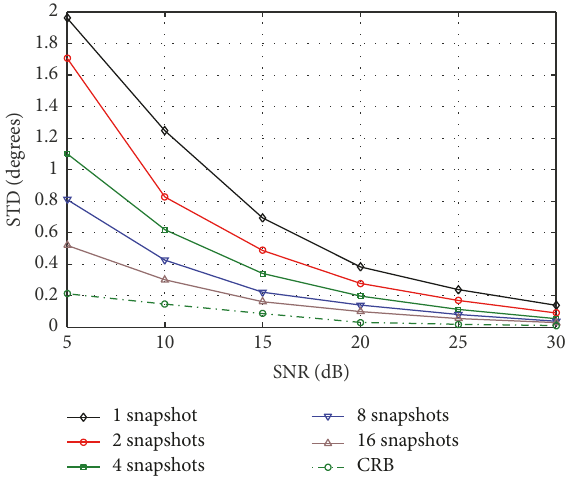
Figure 3: Standard deviation versus SNR for source 1 (noncoherent) located at (𝜃 1 = 70 ∘ , 𝜙 1 = 50 ∘ ) for the proposed method.